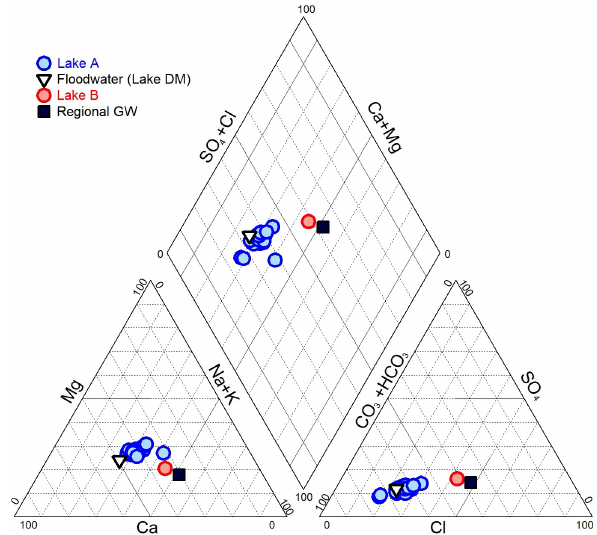
Figure 5. Geochemical facies of lake A ( n = 23) and floodwater ( n = 1). Mean values for lake B ( n = 42) and regional groundwa- ter (GW) ( n = 11) geochemical facies are also plotted. Lake A and floodwater are characterized by Ca-HCO 3 water types, while lake B and regional GW correspond to Na-Cl water types. Note that re- gional GW was sampled upstream of lake